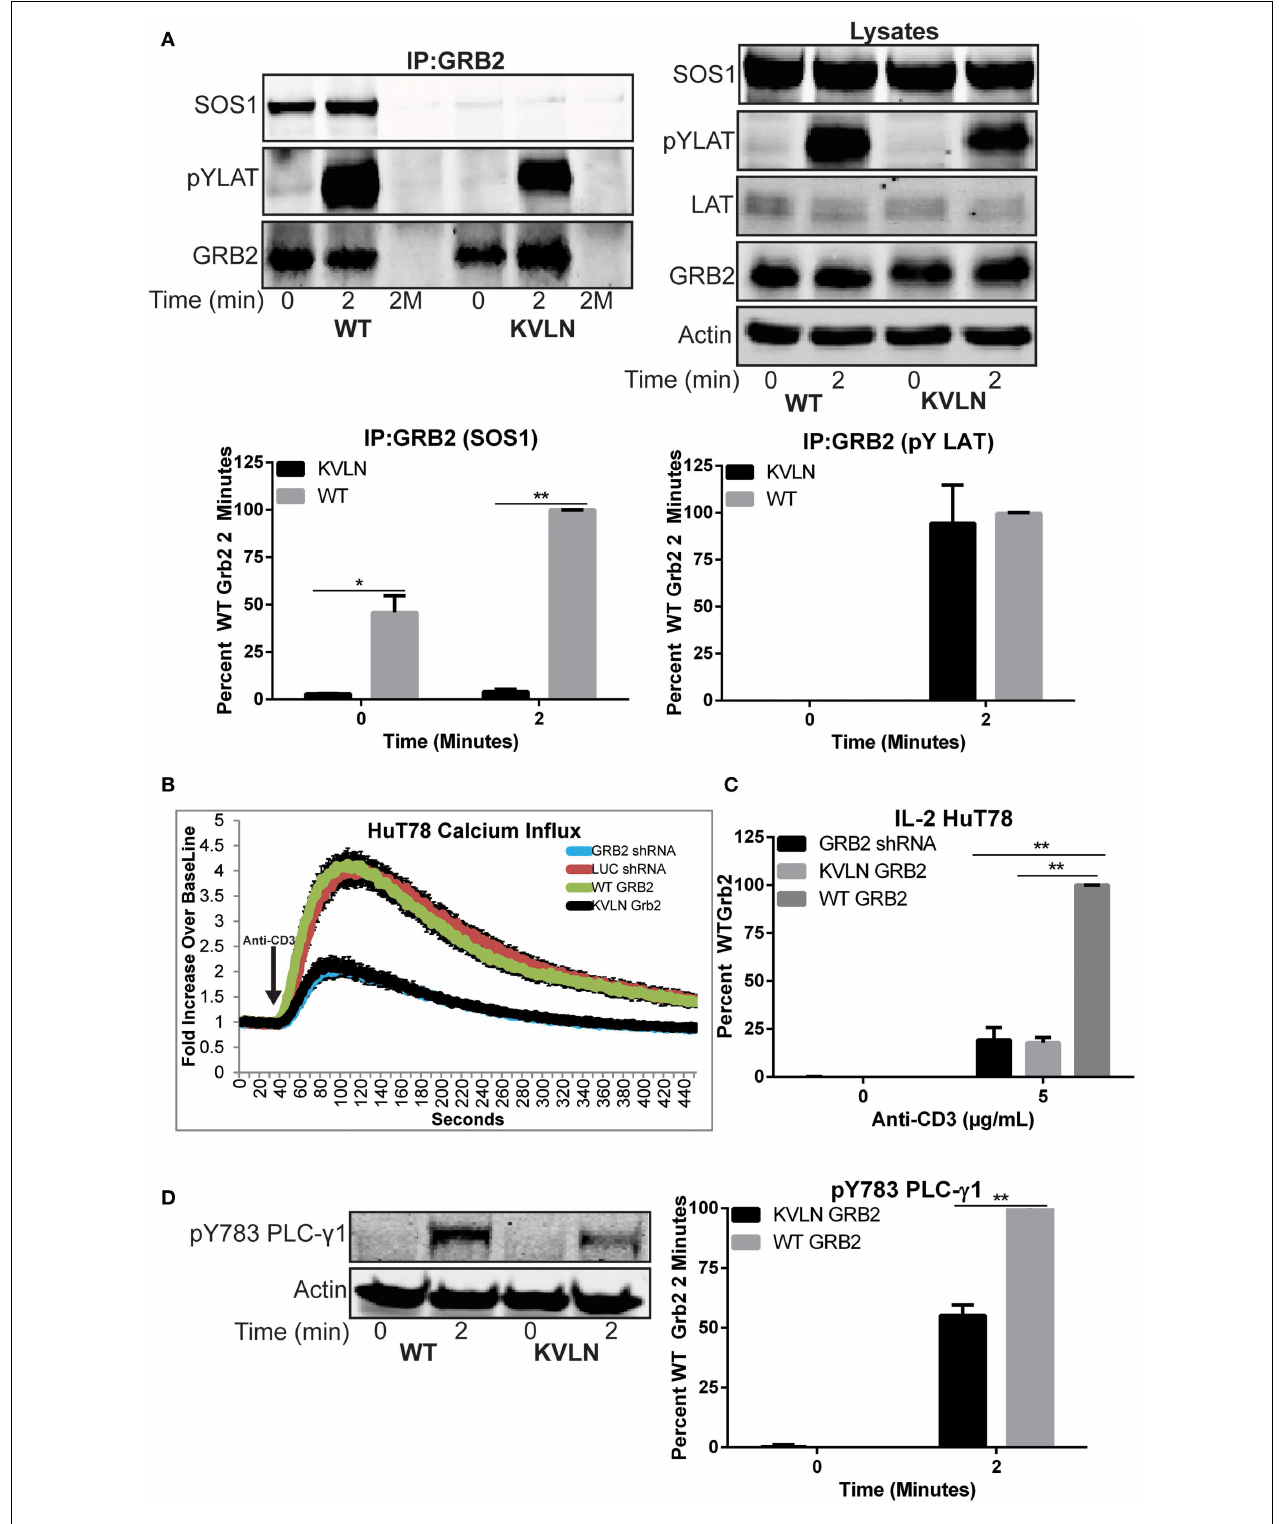
FIGURE 7 | Rescue ofT cell function after reconstitution of wild-type but not KVLN GRB2